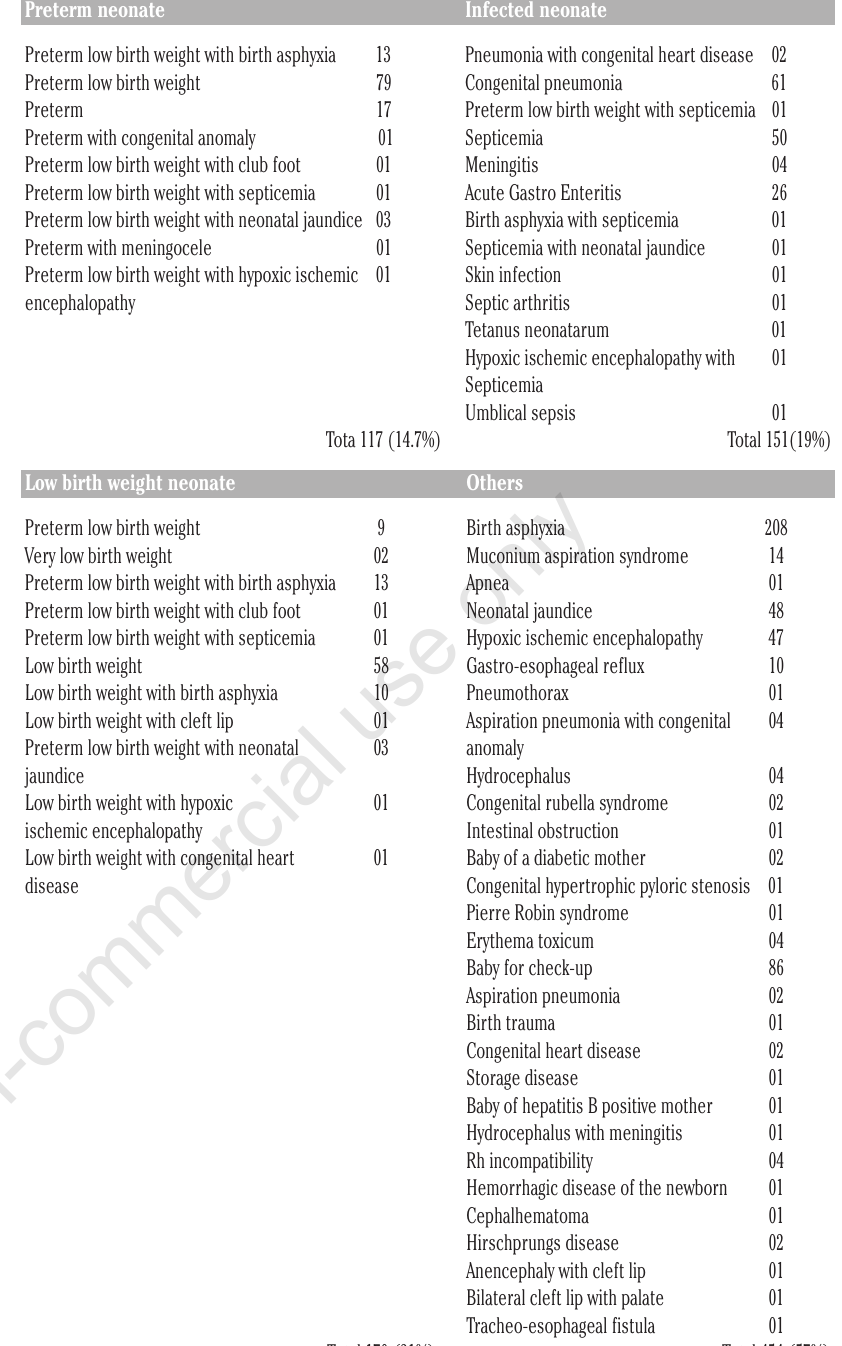
Table 2. Pattern of cases in discharged and referred neonates (Total